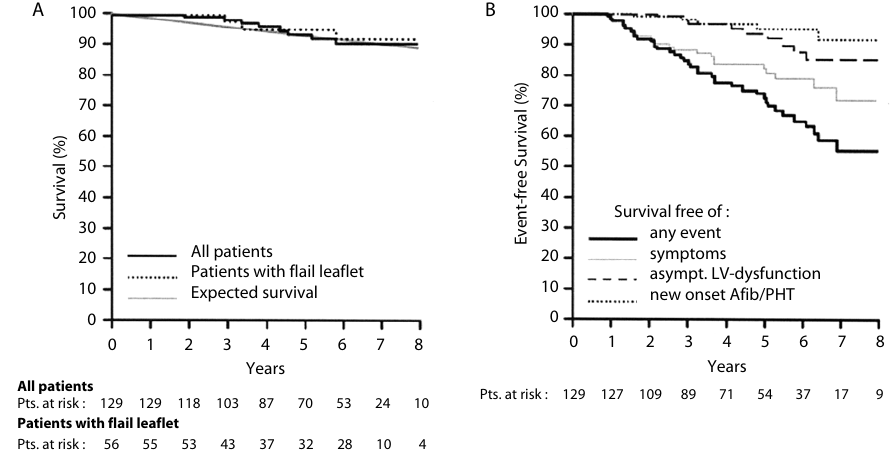
Figure. 5 Survival for patients with severe MR initially observed but then treated with surgery when symptoms or LV dysfunction occurred is shown in the left panel (5A) and is not different from a normal population. However the time until adverse events developed was short (right panel, 5B). Taken from Ref. [59] with